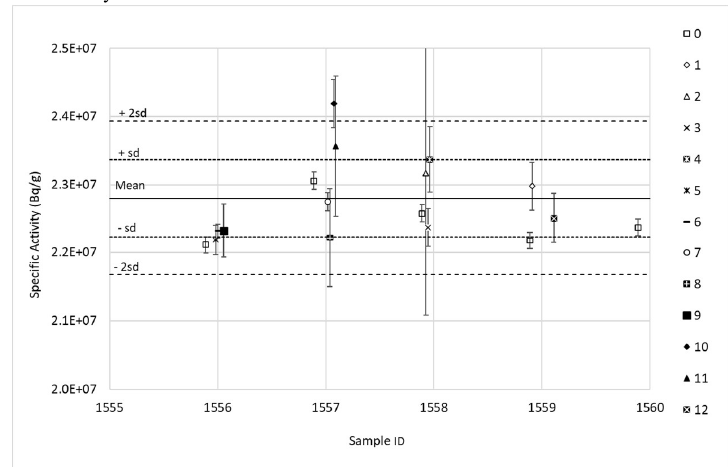
Fig. 7 Mass adjusted activity measurements for 58 Co